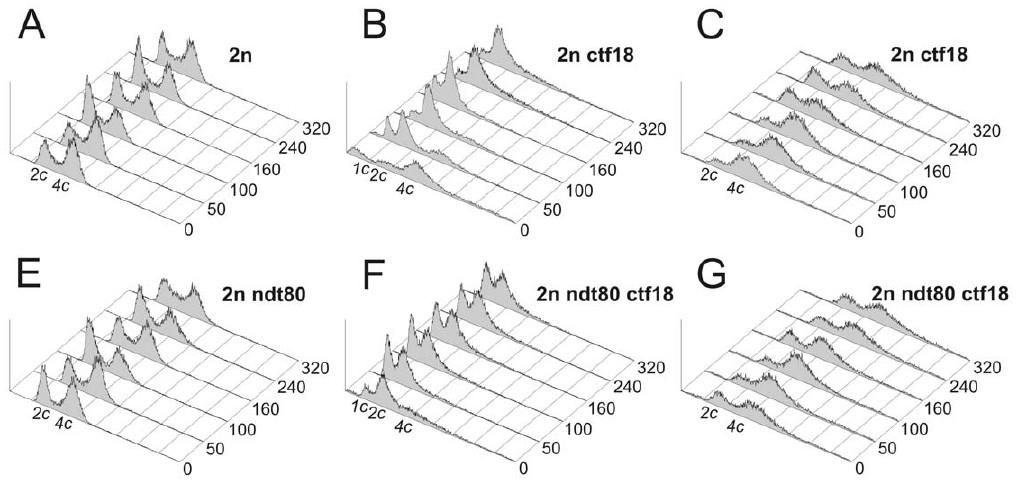
Figure 4. The changes of DNA content in cells of 2n, 2n ndt80, 2n ctf18 and 2n ndt80 ctf18 strains during prolonged growth. DNA content analysis was done after: 0, 50, 100, 160, 240 and 320 generations. Please note that ‘‘0’’ represents the starting point of the experiment. In fact, as we estimate, at this point the clones originating from the single zygotes had already grown for about 50 generations. Propidium iodide stained cells were analyzed by FACS as described in Materials and